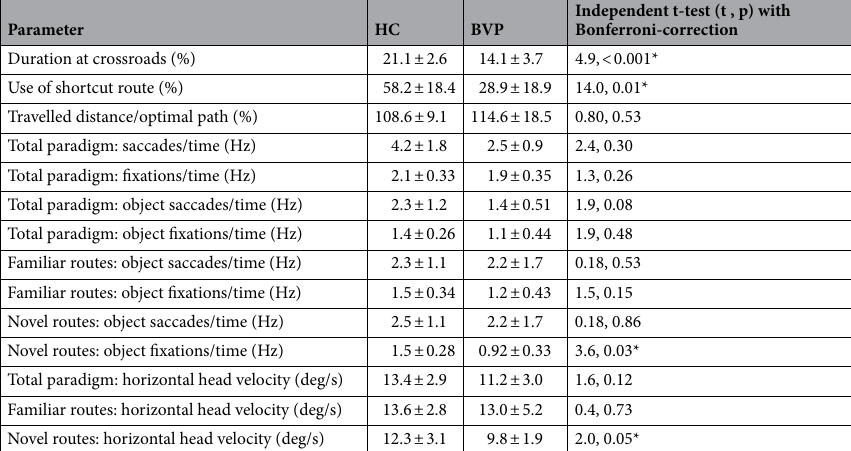
Table 1. Visual exploration and navigational parameters in healthy controls and BVP patients. The duration at crossroads and use of the possible shortcut routes were significantly lower in the BVP group. Total saccades and fixations, as well as fixations and saccades to objects feasible as landmarks for orientation did not differ between both groups. When retracing familiar routes (routes shown during the exploration phase), object fixations and saccades were similar between both groups. In contrast, when recombining novel routes (routes not shown during the exploration phase) object fixations were lower in the BVP group. Total horizontal head movements and horizontal head movements on familiar routes were comparable between both groups. However, there were fewer horizontal head movements in the BVP group on recombined novel routes. BVP: bilateral vestibulopathy, deg: degree, HC: healthy controls, Hz: Hertz. *Significant inter-group differences after applying Bonferroni-correction for multiple